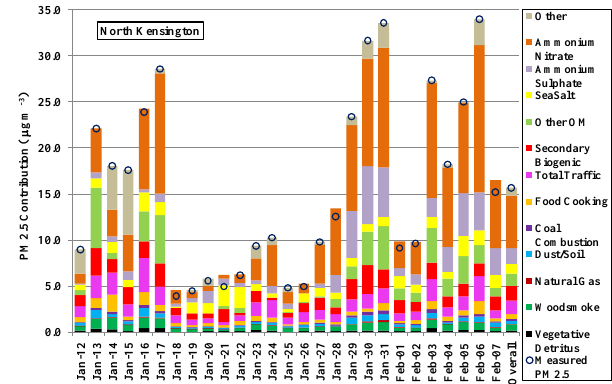
Figure 3. Daily PM 2 . 5 source contribution estimates with sec- ondary biogenic components at NK.